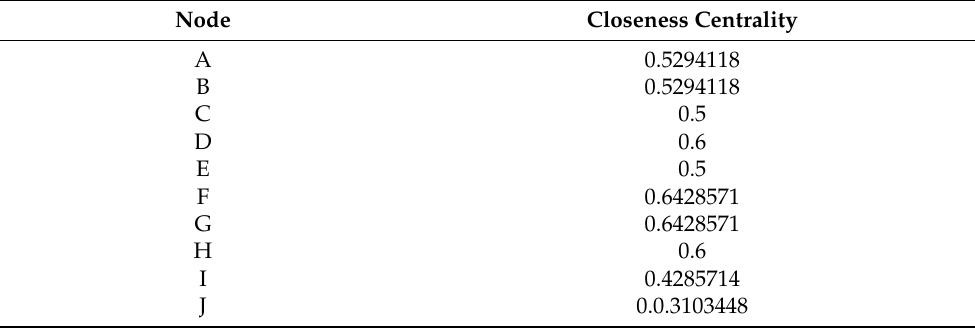
Table 2. The closeness centrality of each node in kite network. Node Closeness Centrality A